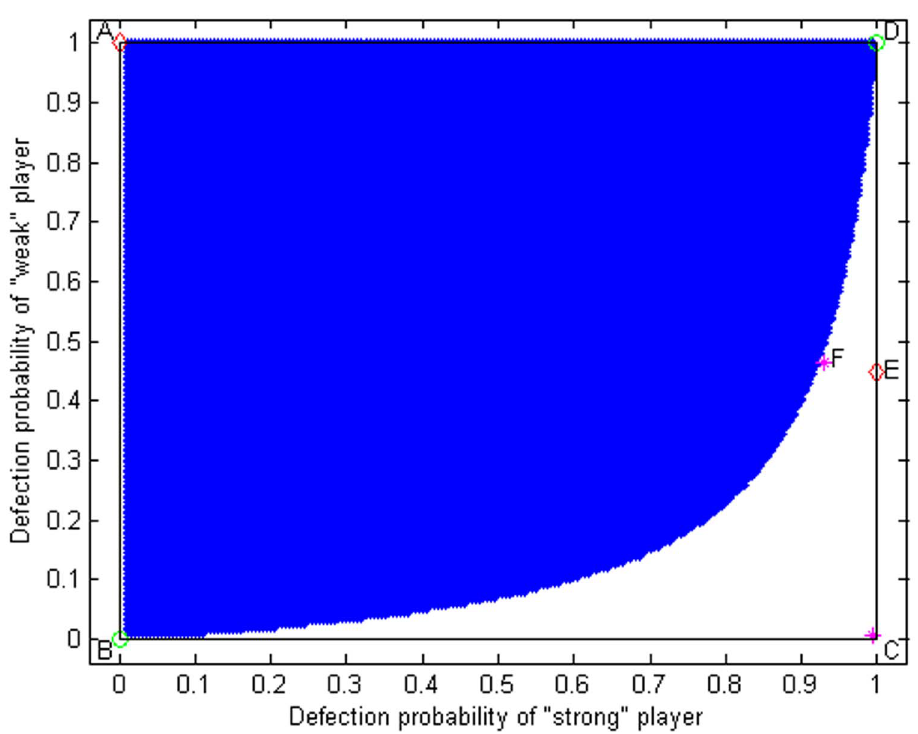
Figure 2. The basin of attraction of the local stable equilibrium points A (‘‘shadow region’’) and E (‘‘blank region’’). The parameters are fixed at K S ~ 0 : 1, K W ~ 0 : 2, U S ~ 1, U W ~ 1 and N ~ 4 .